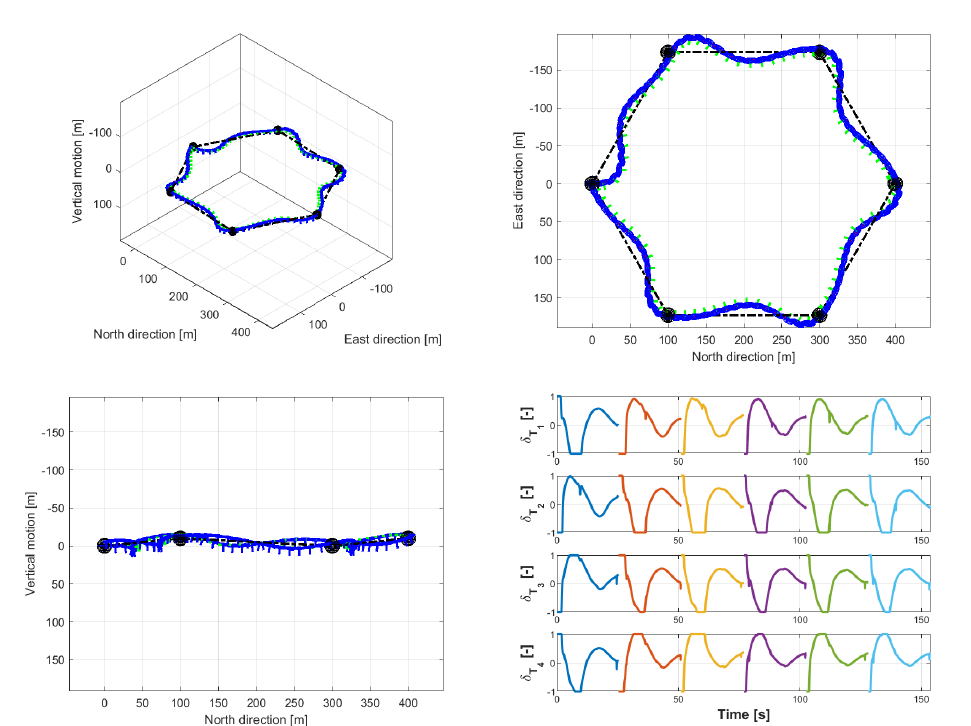
Figure 16. Trajectory and control behavior for a 6-checkpoints circuit, flown by the thrust controller on the stabilized four-thrusters concept airship, at 8 m/s of ground speed. ( Top-left ) three-quarter view of the 3D trajectory from the northeast. ( Bottom-left ) view of the trajectory from the east. ( Top-right ) view of the trajectory from the top. Black dash-dotted lines: target track. Black spheres: target checkpoint capture volume. ( Bottom-right ) time histories of controls (a color for each